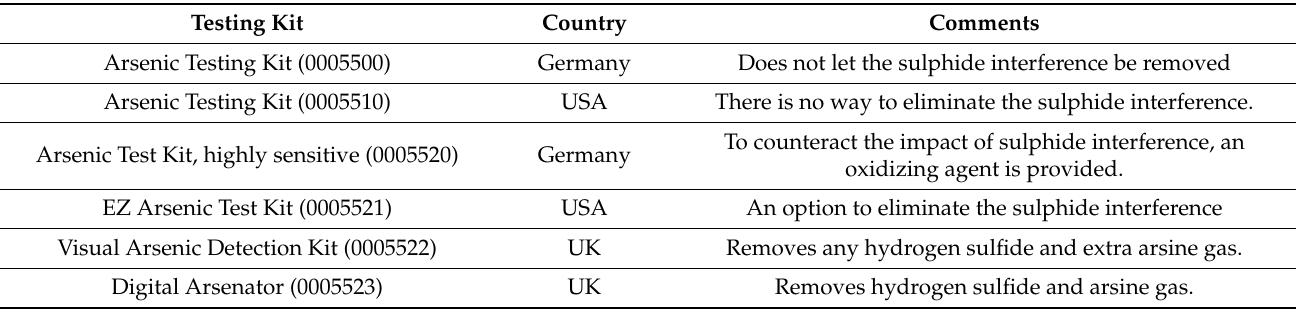
Table 10. Arsenic field-testing kits used in many countries (UNICEF Supply Catalogue, Copenhagen)